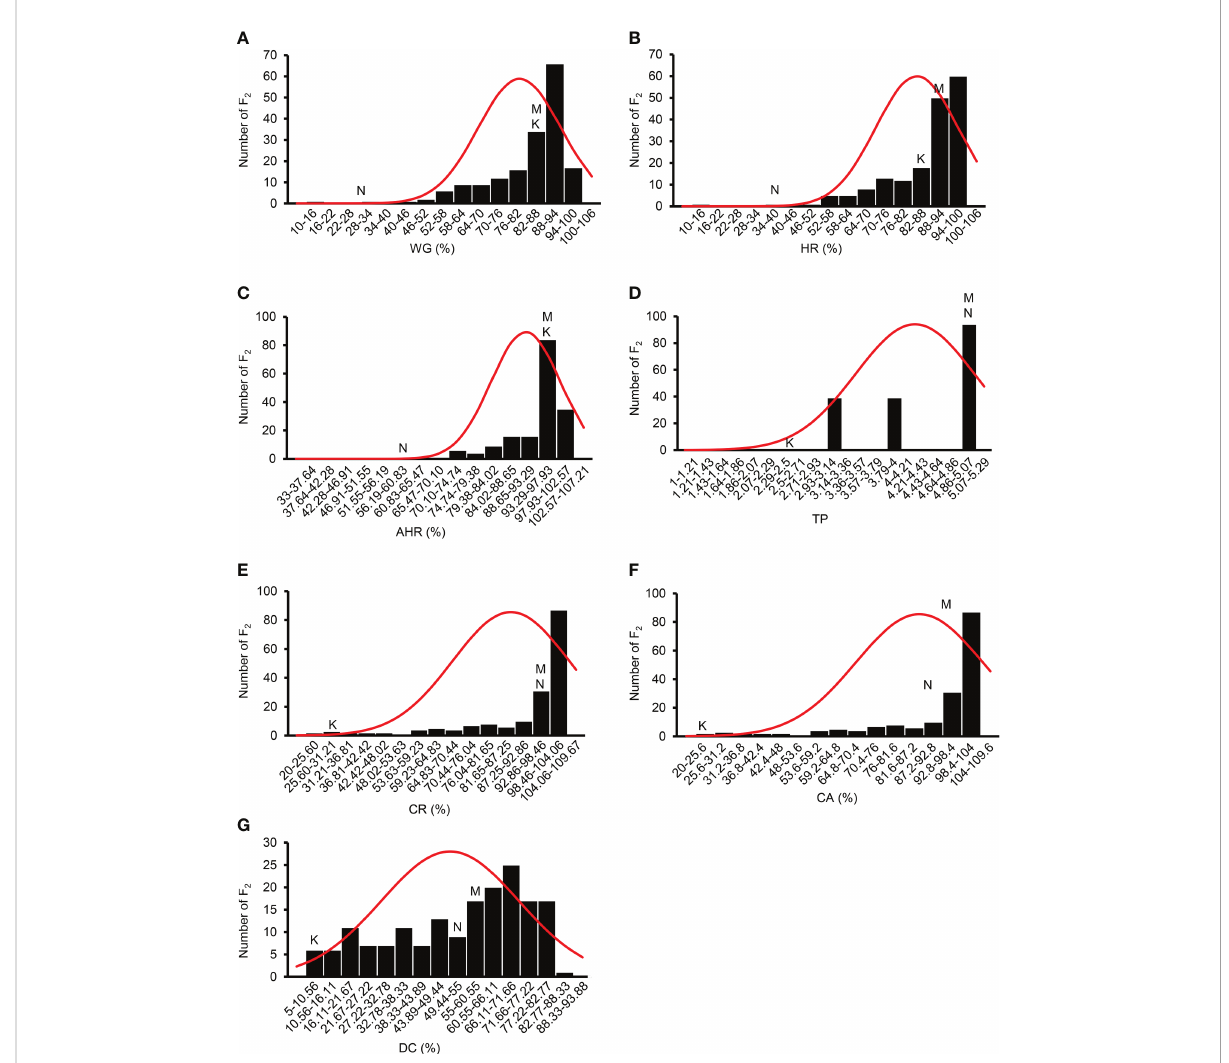
FIGURE 4 Frequency distribution of the grain quality traits of the F 2 population. (A) WG, percentage of whole grain; (B) HR, percentage of head rice; (C) AHR, percentage of the area of head rice; (D) TP, transparency; (E) CR, percentage of chalky rice; (F) CA, percentage of chalkiness area; (G) DC, degree of chalkiness; K, Koshihikari; N, Nona Bokra; M,